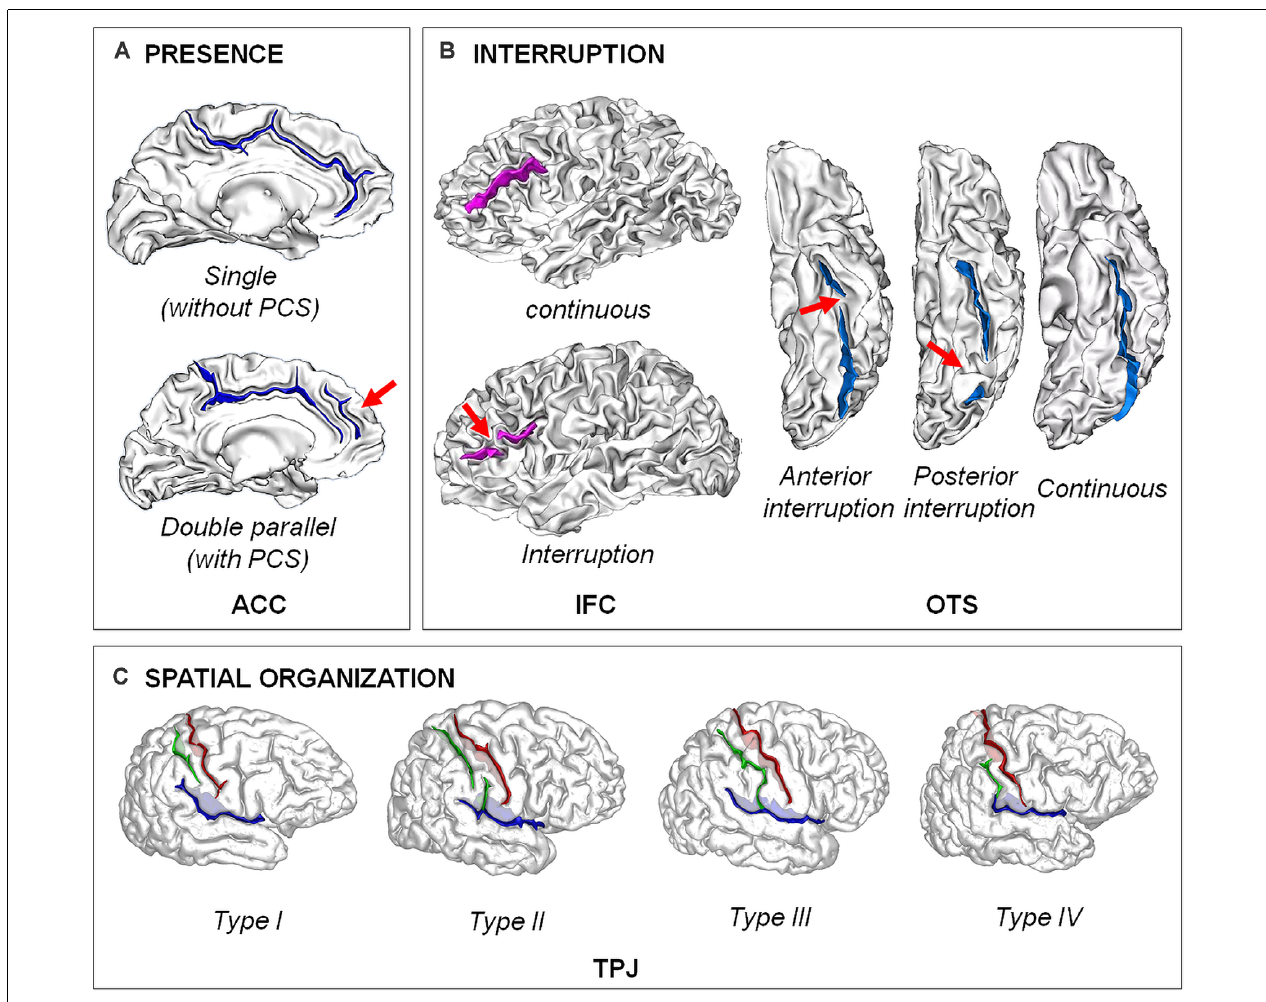
FIGURE 1 | Examples of different types of sulcal patterns. (A) Presence of the fold. The sulcal pattern of the anterior cingulate cortex (ACC) can be “single”, with only the cingulate sulcus, or “double parallel”, with an additional paracingulate sulcus (PCS). Adapted from Cachia et al. (2014). (B) Interruption of the fold. The sulcal pattern of the inferior frontal cortex (IFC) can be continuous or with an interruption (red arrow). The sulcal pattern of the lateral occipito-temporal sulcus (OTS) can be continuous or have an anterior or a posterior sulcal interruption. Adapted from Cachia et al. (2014), Borst et al. (2016), Cachia et al. (2018), and Tissier et al. (2018). (C) Spatial organization. The sulcal pattern of the temporo-parietal junction (TPJ) is characterized by the spatial organization of the posterior part of the right Sylvian fissure (pSF) including Sylvian fissure (in blue), post-central sulcus (green) and central sulcus (in red). Type I, has both a vertical branch (planum parietale) that ascends into the supramarginal gyrus and a horizontal branch (planum temporale) that forms the superior surface of the superior temporal gyrus. In Type II, the Sylvian fissure lacks a vertical branch. In Type III, the horizontal branch extends posteriorly to the supramarginal gyrus into the angular gyrus. In Type IV, the vertical branch connects the post-central sulcus anterior to the supramarginal gyrus, the horizontal branch is therefore absent. Adapted from Steinmetz et al. (1990) and Plaze et al.